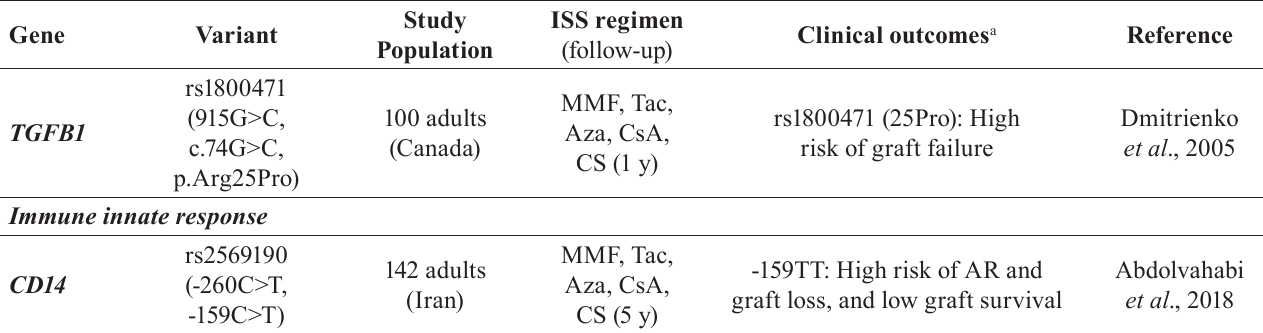
TABLE III - Genes related to cytokines and immune innate response in kidney recipients on MPA therapy with significant associations Gene